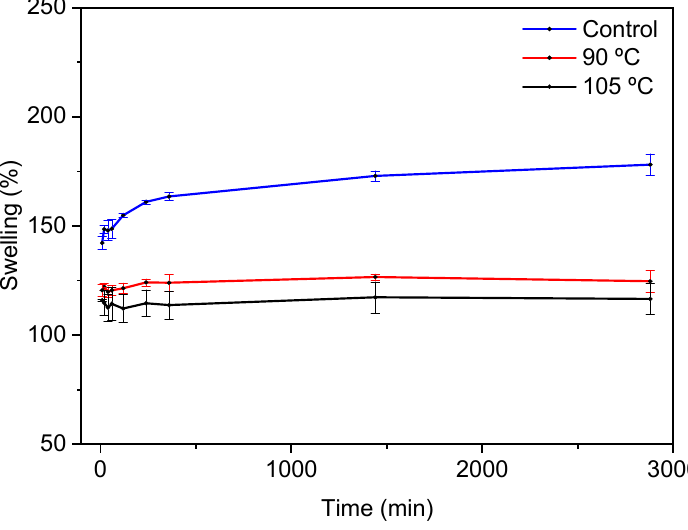
Figure 1. Swelling behaviour of control and thermally treated films.